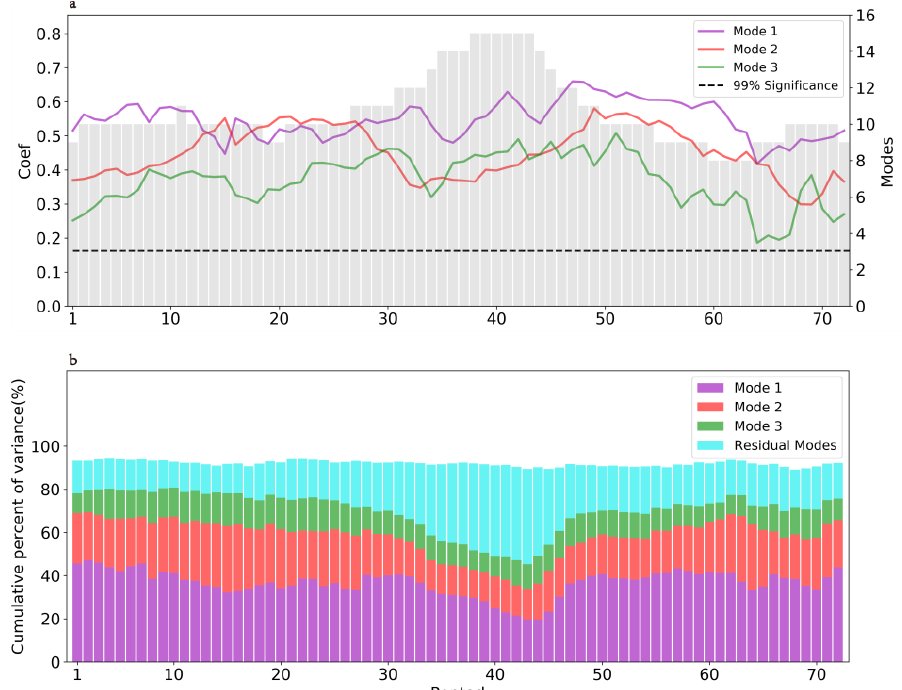
Figure 4. ( a ) Linear regression coefficients ( β i in Equation (3), lines) of the available modes in DSDM (gray bars) and ( b ) cumulative percentage of variance (%) of the first three SVD modes and the residual modes in the DSDM (the black dotted line denotes the 99% significance test in ( a ).